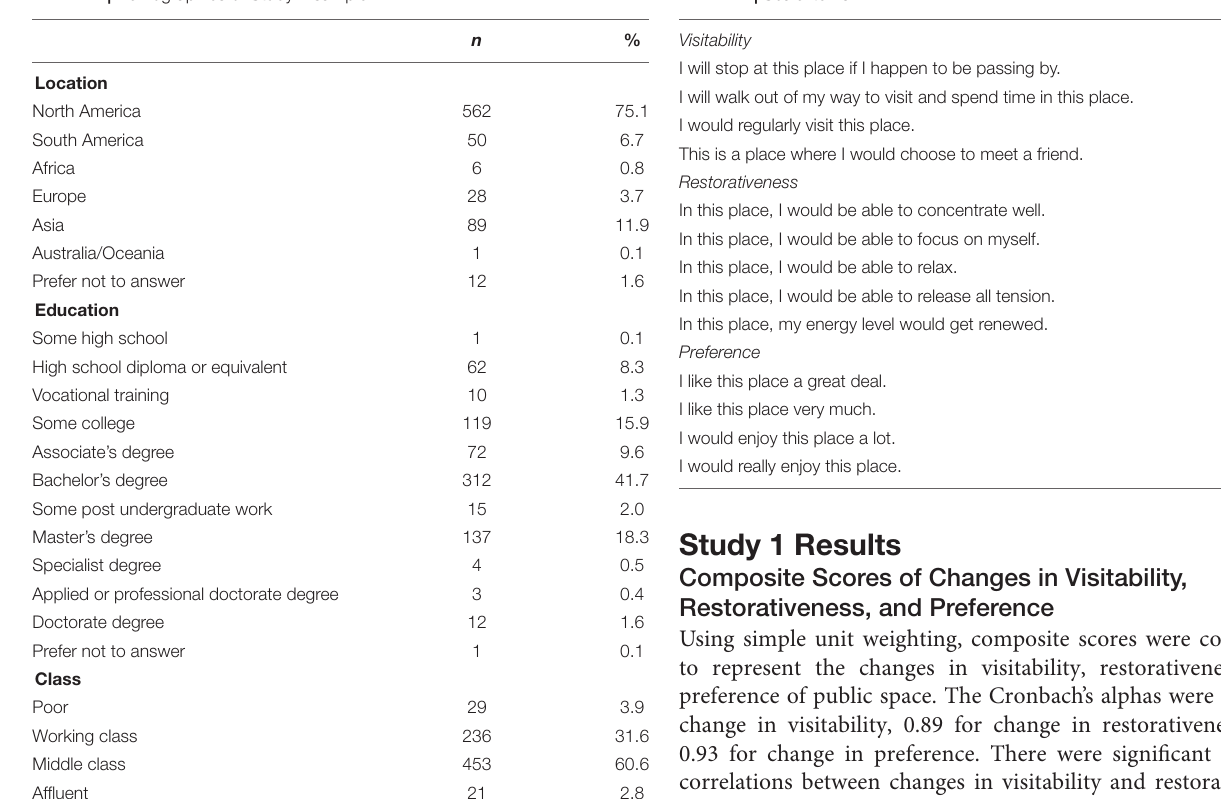
TABLE 2 | Demographics of Study 1 sample.